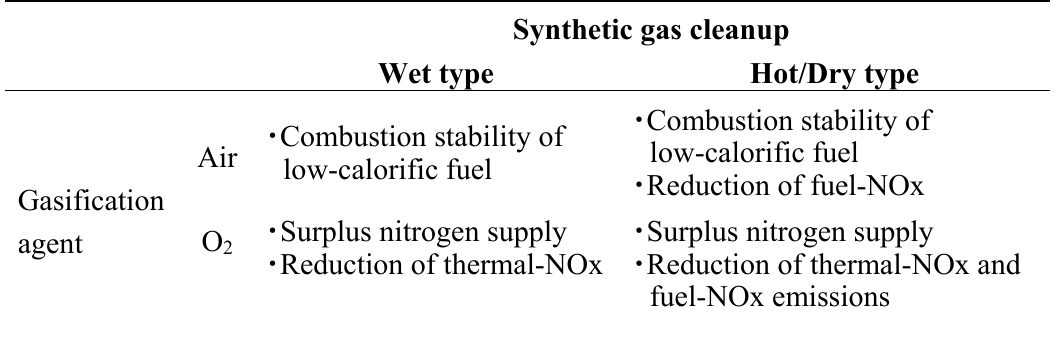
Table 3. Subjects for combustors of various gasified